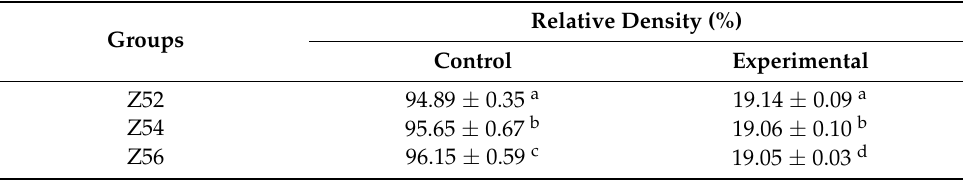
Table 3. Relative density of printed zirconia; different letters represent significant differences ( p <